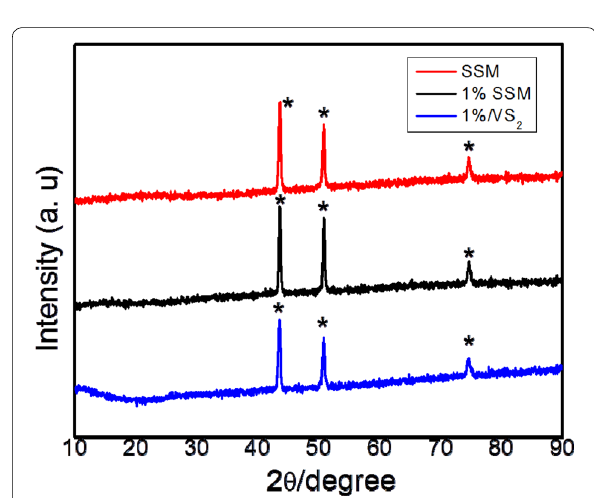
Fig. 4 X‑ray diffraction patterns of stainless steel mesh (SSM), 1% etched SSM and 1%/VS 2 SSM samples. The peaks of the SSM are denoted by